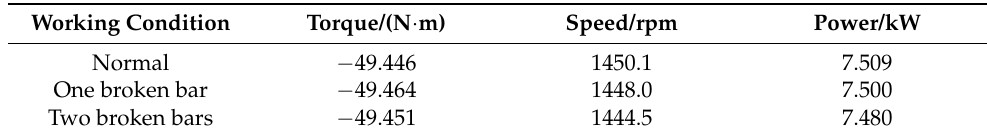
Table 3. Output parameters of the experimental motor.